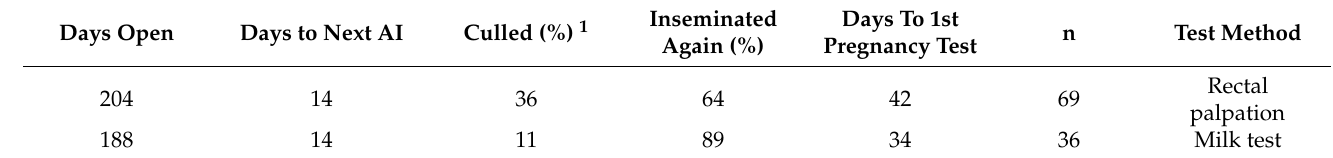
Table 2. First negative pregnancy test in both treatment groups.